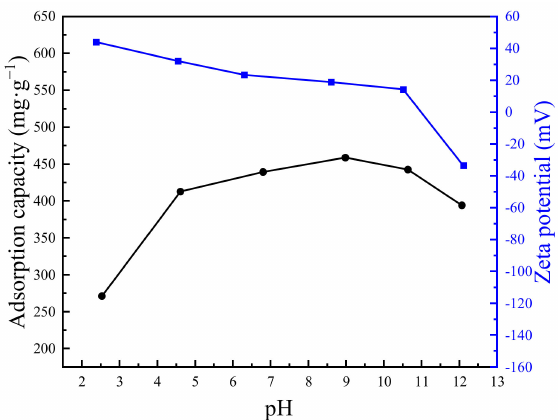
Figure 10. Adsorption capacity and zeta potential of Cu-ZIF-8-1 with the different pH values ( c 0 = 522 mg · L − 1